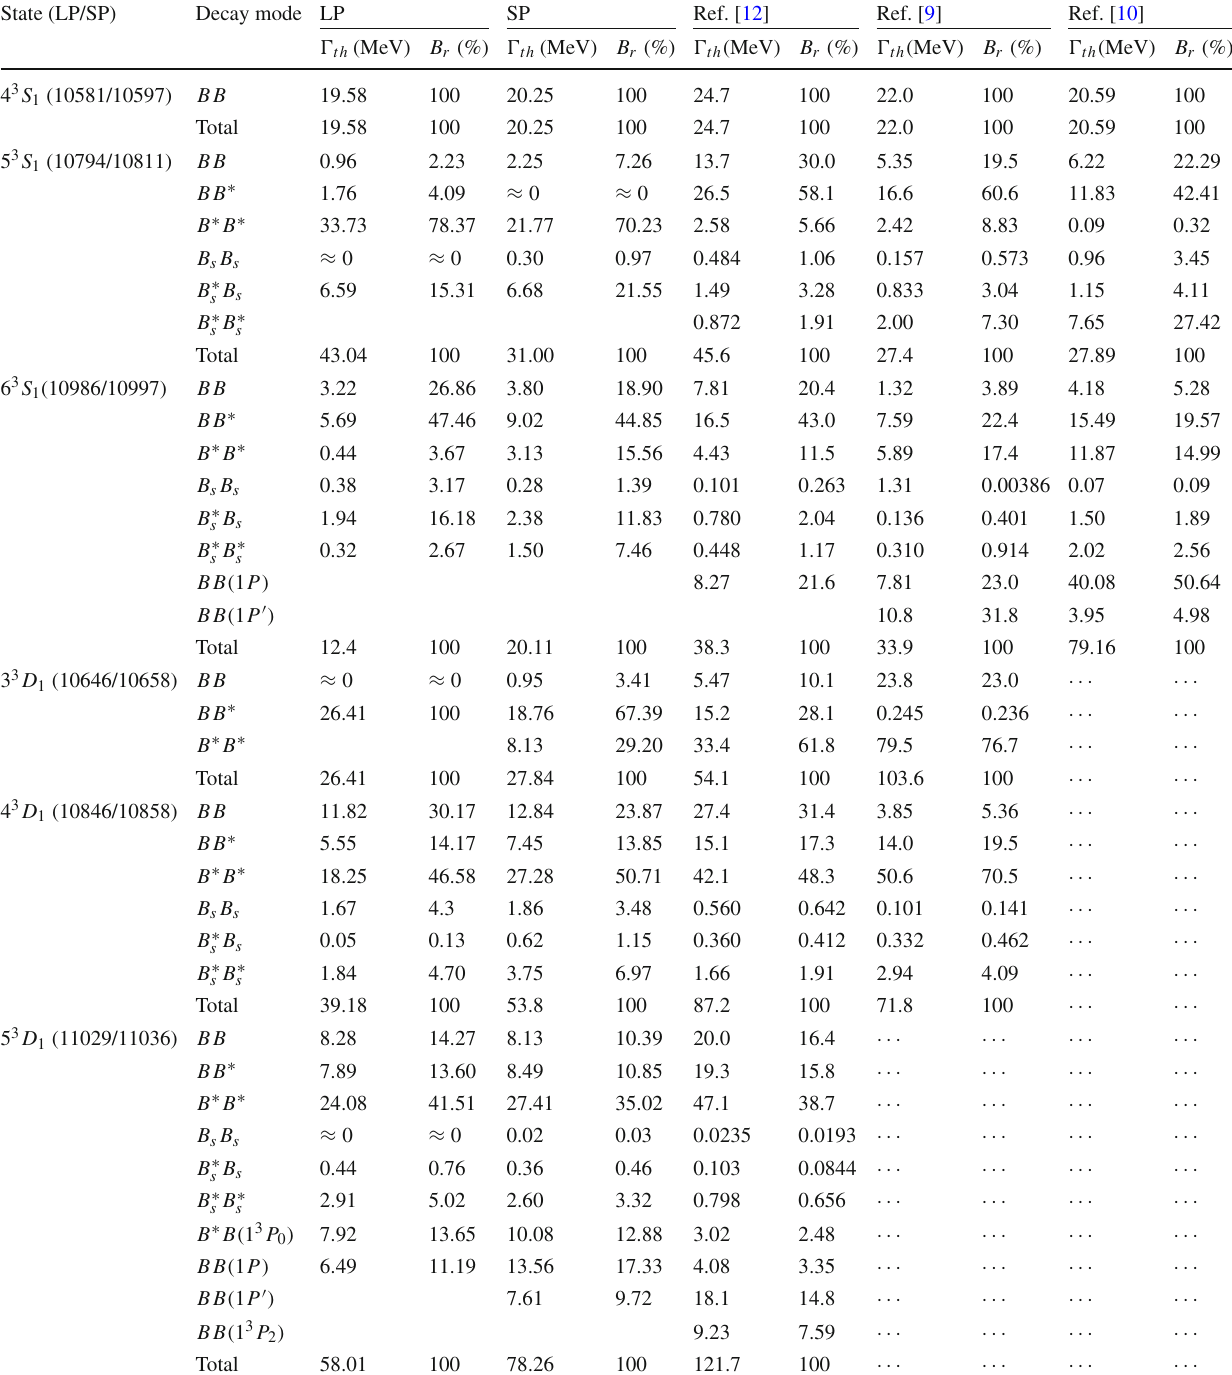
Table 3 Strong decay properties for the higher vector bottomonium states predicted within both LP and SP models State (LP/SP) Decay mode LP